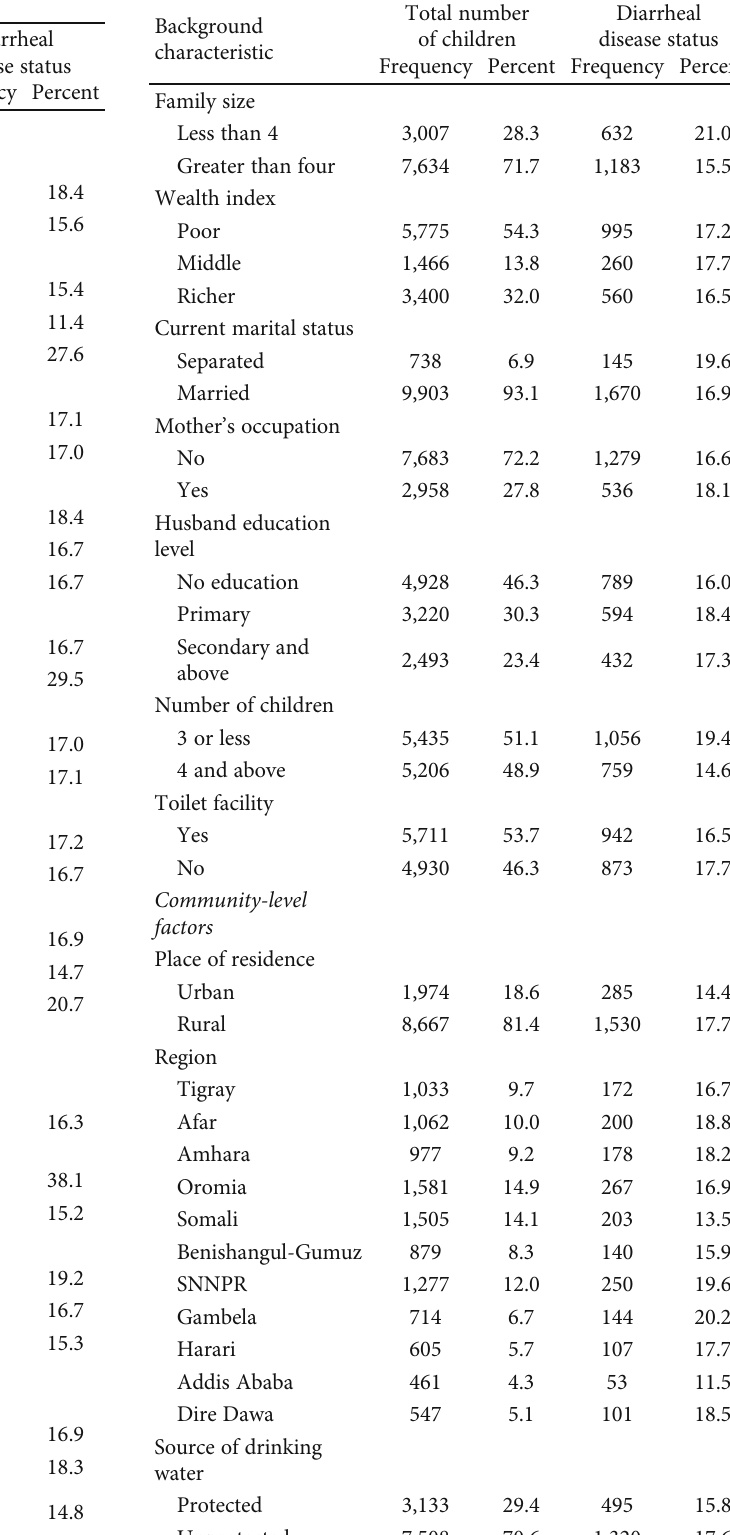
Table 1: Prevalence of childhood diarrhea by background characteristics in Ethiopia,